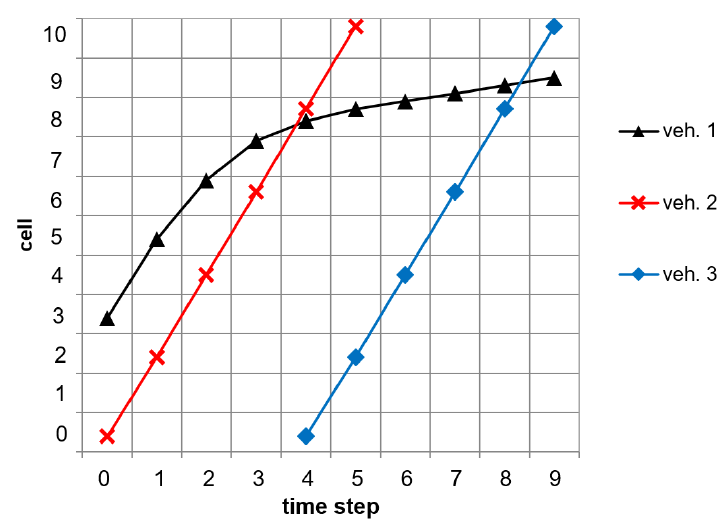
Figure 3. Intersecting time-space